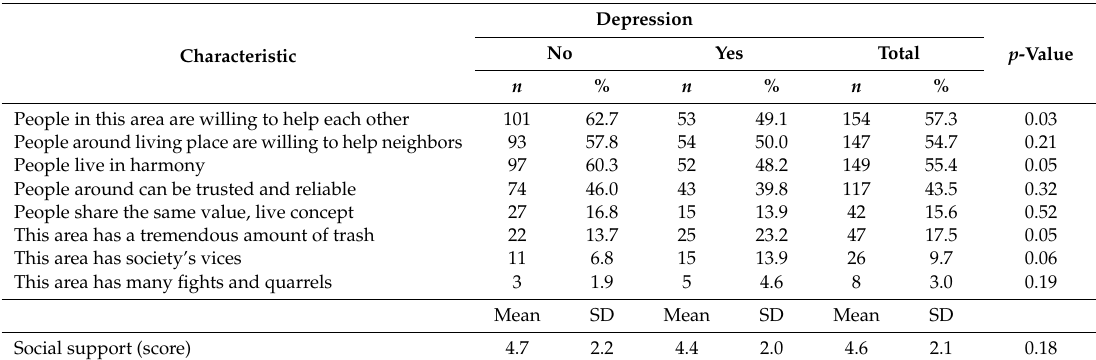
Table 4. Social support and community